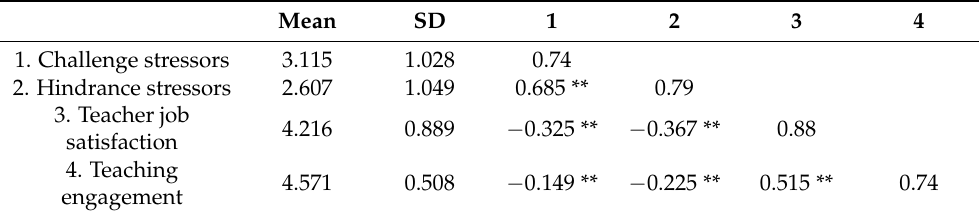
Table 2. Mean, standard deviation, and correlation matrix (N = 7743).